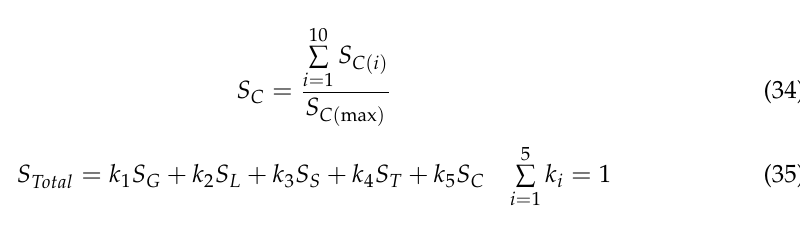
Table 1. Relationship between the RMS value of the total weighted acceleration and passenger comfort level in [28].